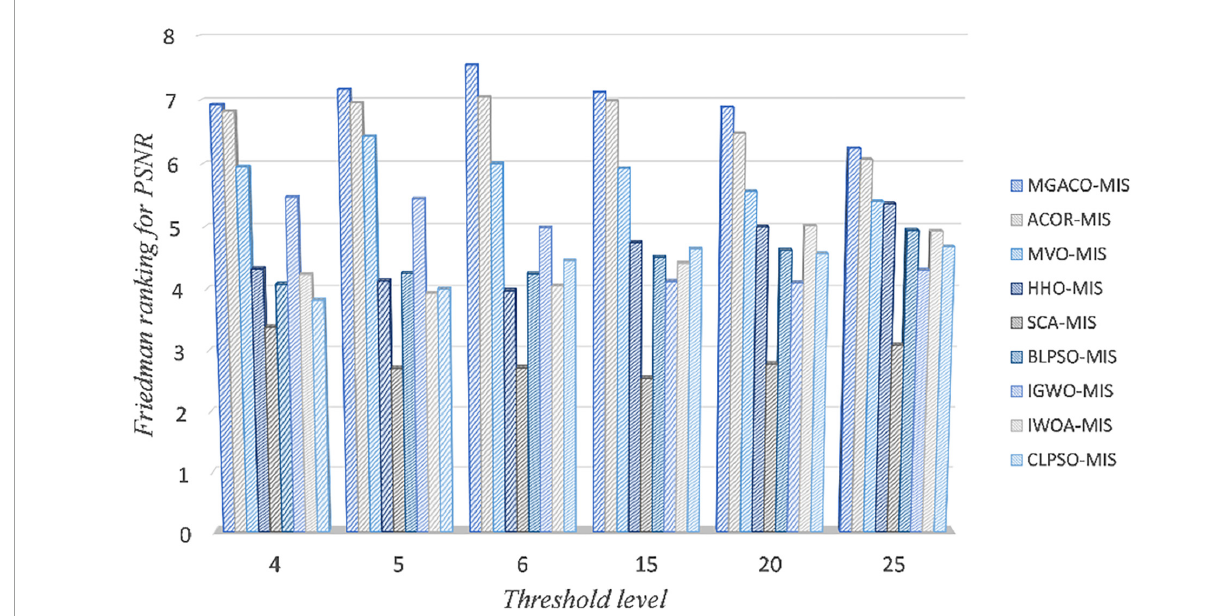
FIGURE11 Friedman test results of MGACO-MIS and its peers for PSNR evaluation.